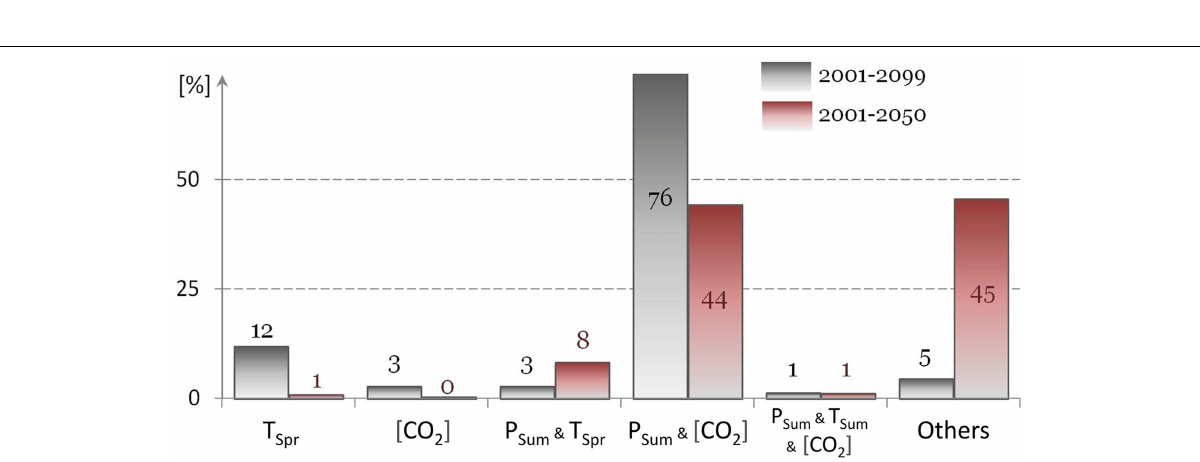
FIGURE 7 | Spatial percentage variation between crop yields modeled with constant and changing [CO 2 ]. A value of + 20% would indicate that biomass yields are 20% higher when modeled using increasing [CO 2 ] instead of fixed 390 ppm.